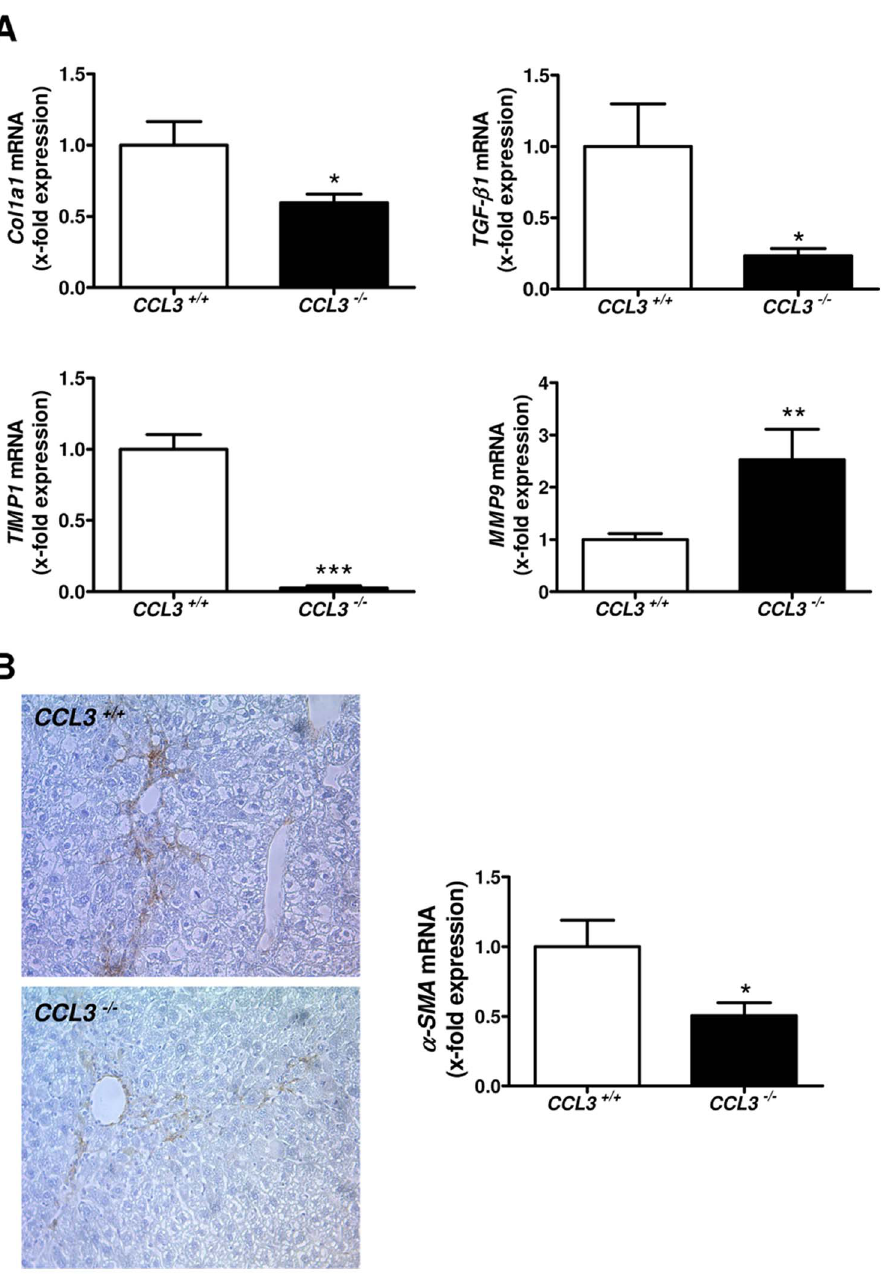
Figure 4. Altered expression of fibrosis-related genes in CCL3 2 / 2 mice. CCl 4 treatment of CCL3 2 / 2 mice lead to significantly altered expression of the fibrosis-related genes Col1a1, TGF- b 1, TIMP1 and MMP9 in CCL3 2 / 2 mice ( A ) . a -SMA expression is significantly decreased in CCL3 2 / 2 mice (x100 magnification, B ). Data are expressed as means 6 SEM of eight mice per group. * P , 0.05, ** P , 0.01, *** P , 0.001. doi:10.1371/journal.pone.0066106.g004 mice after chronic CCl 4 treatment (Fig. 3B, P , 0.001). These results were further strengthened by markedly reduced concen- trations of the collagen-specific amino acid hydroxyproline (Fig. 3C, P , 0.01). Moreover, ALT values (Fig. 3D, P , 0.05) and TUNEL + cells within the liver (Figure S2A * P , 0.05) were also reduced in CCL3 2 / 2 mice compared to wild-type control, suggesting a directly involvement of CCL3 in inflammatory hepatocyte damage. type counterparts after chronic CCl 4 treatment (Fig. 4A, P , 0.05,